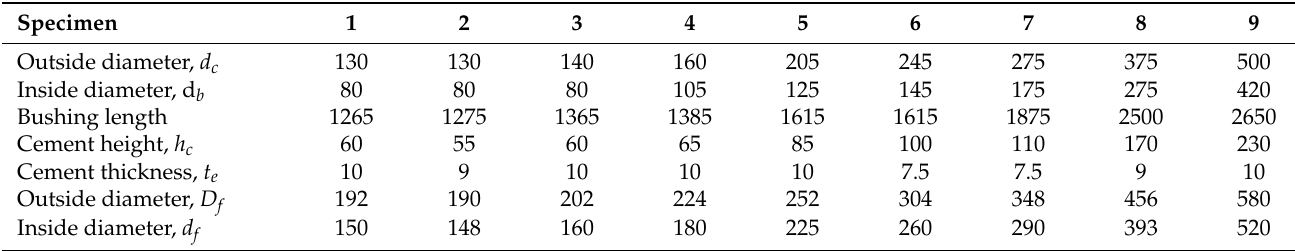
Figure 6. Ultra-high voltage porcelain bushings. Table 1. Specimen size properties